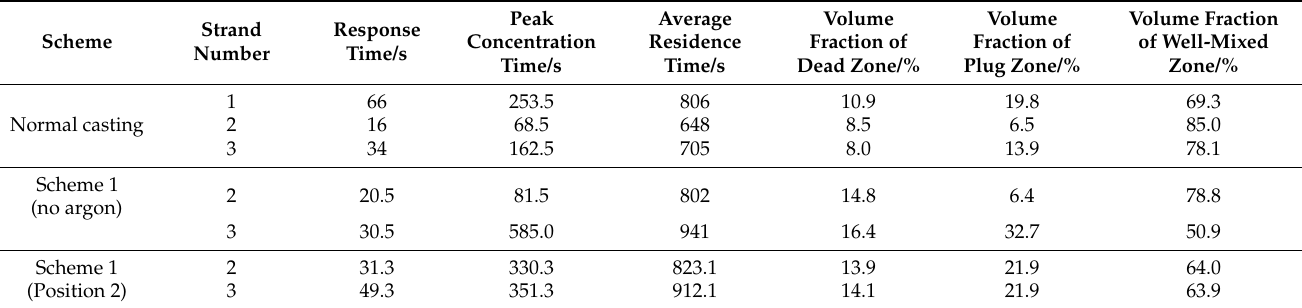
Figure 12. Inclusion removal rate in tundish with each scheme. Table 5. Numerical result of RTD curves in tundish with each